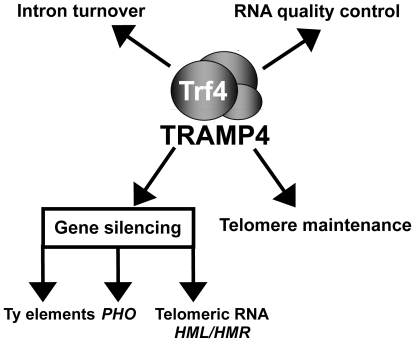
Combined view on the current knowledge of the different roles of the TRAMP4 complex.
PHO; mRNAs encoding proteins involved in phosphate metabolism.